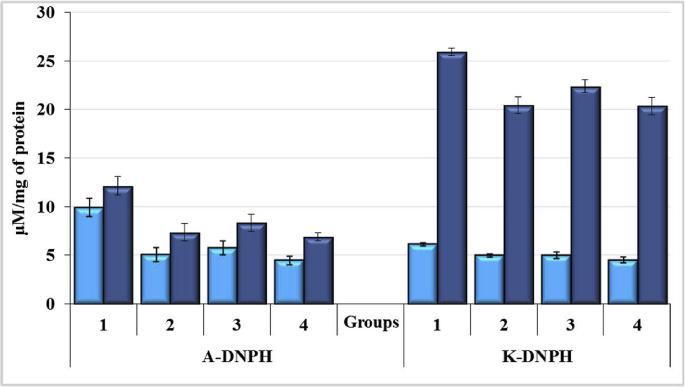
The level of oxidative modification (spontaneous Image 1 and induced Image 2 levels) of proteins in liver homogenates of rats exposed to CCl4 with or without enterosorption using AC1 and AC2 formulations, p < 0.05.